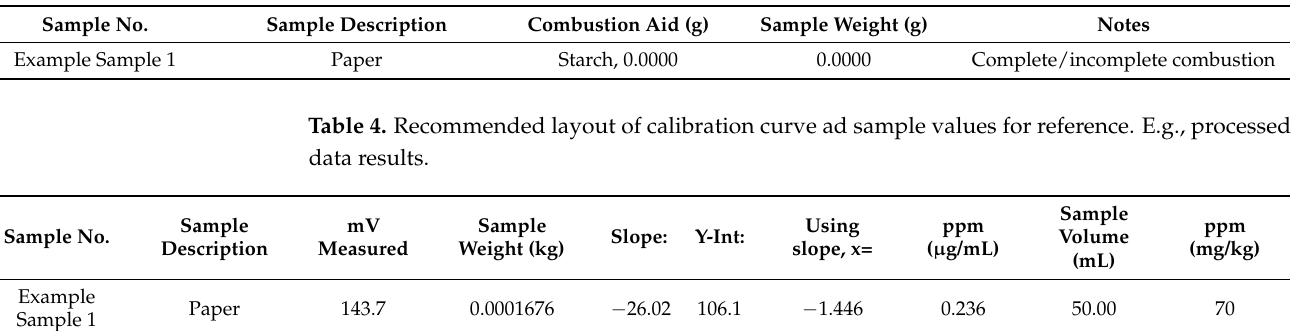
Table 3. Recommended table for sample preparation for total fluorine analysis. E.g. prepared sample data.